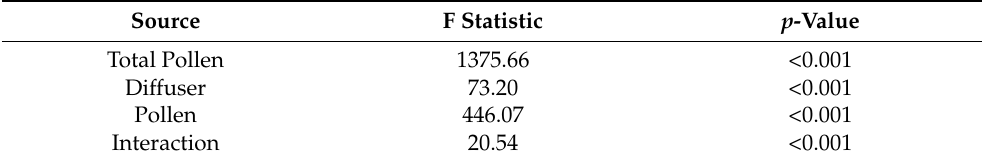
Figure 6. Plot of residuals for fit of the overall pollen model, combining both the pine pollen data with the pecan pollen data. Note the repeating trend after data point 676, indicating the switch to pecan pollen. Table 1. Summary of the overall analysis of